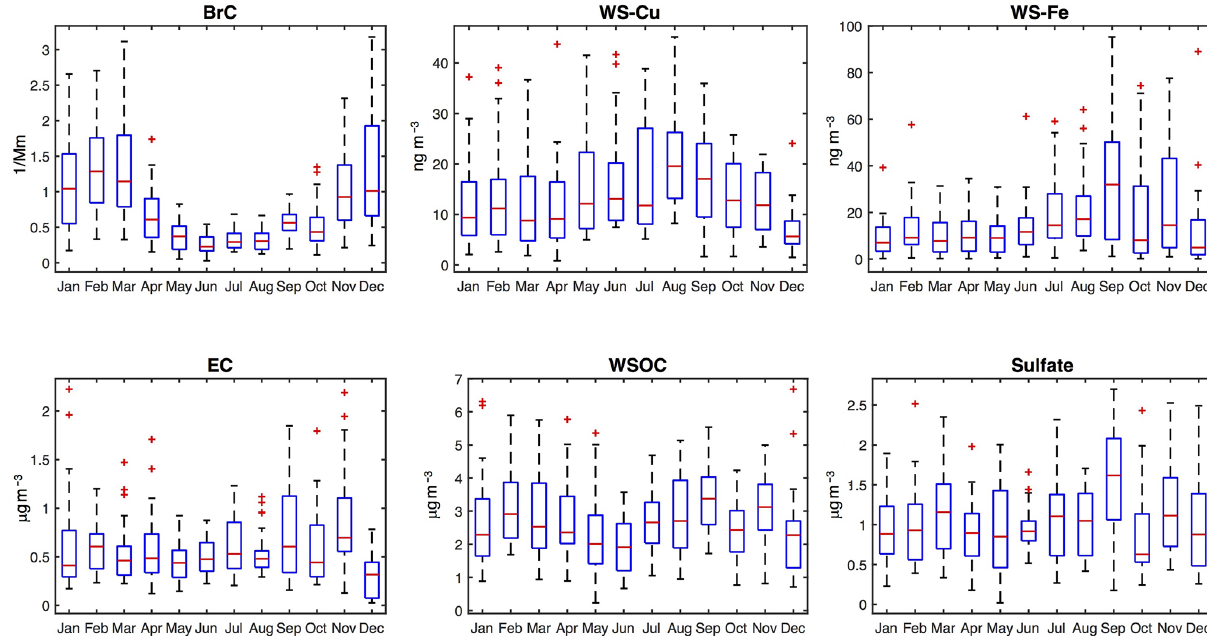
Figure 3. Temporal variation for select PM